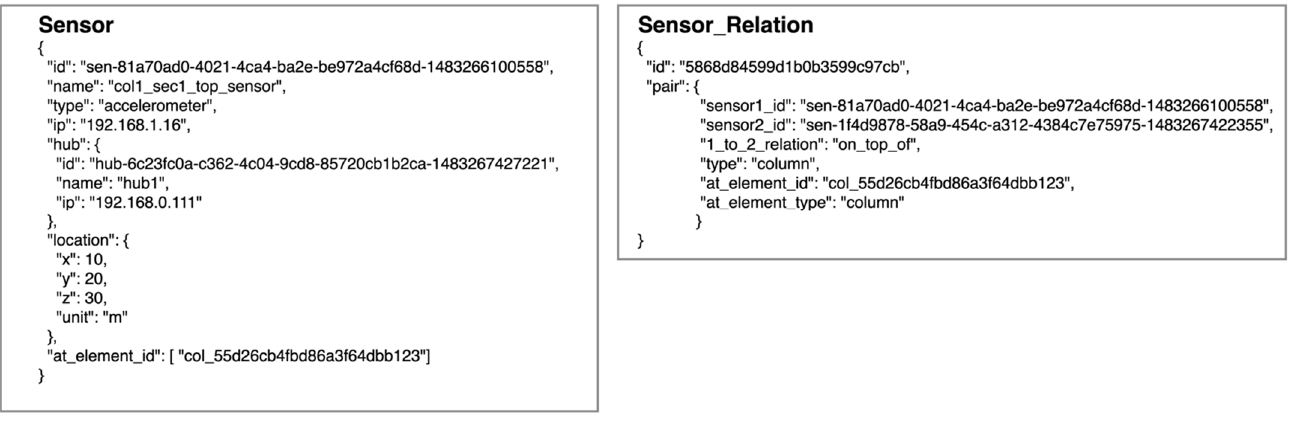
Figure 10. Example of sensor and sensor relation data.